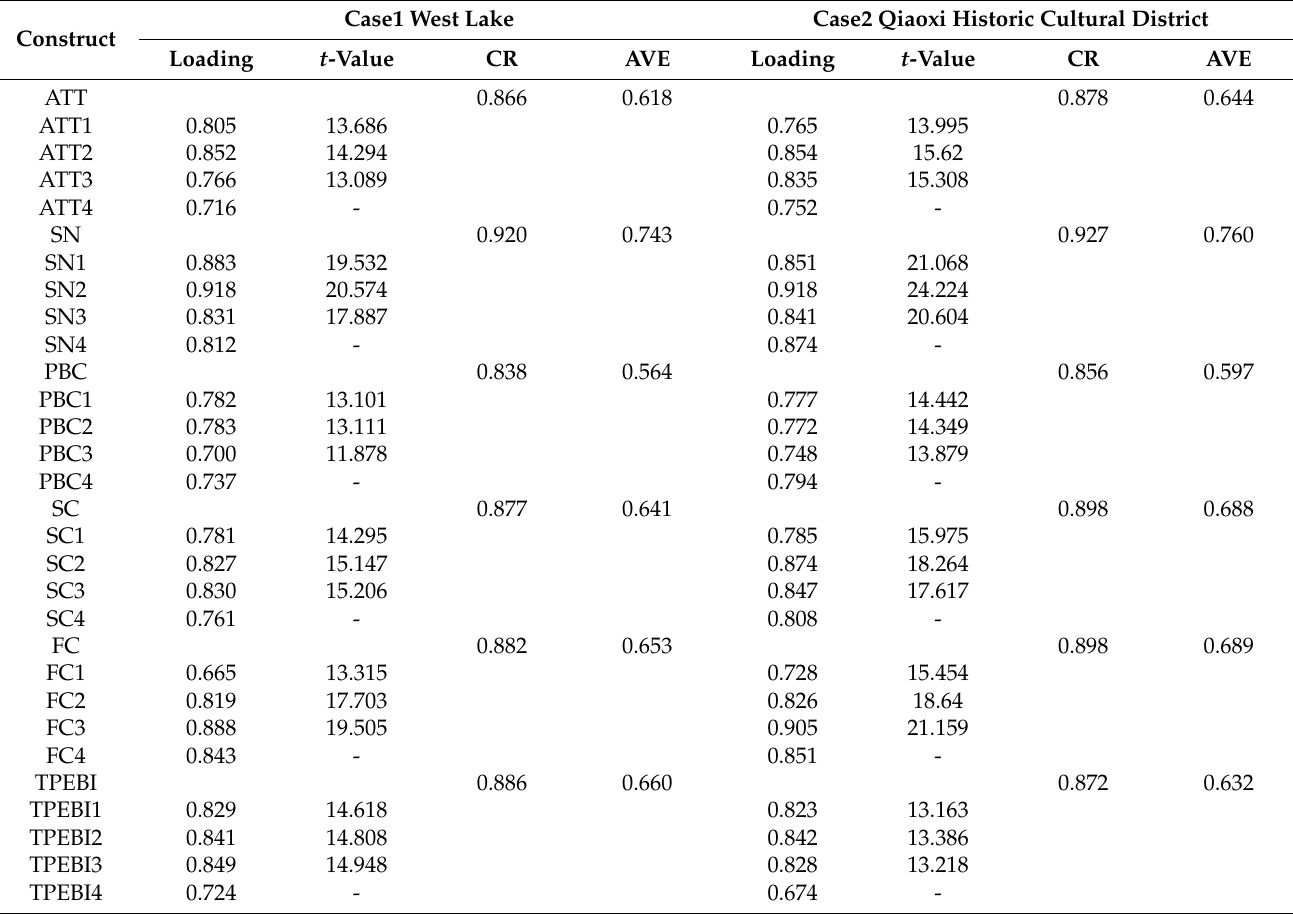
Table 2. The measurement model